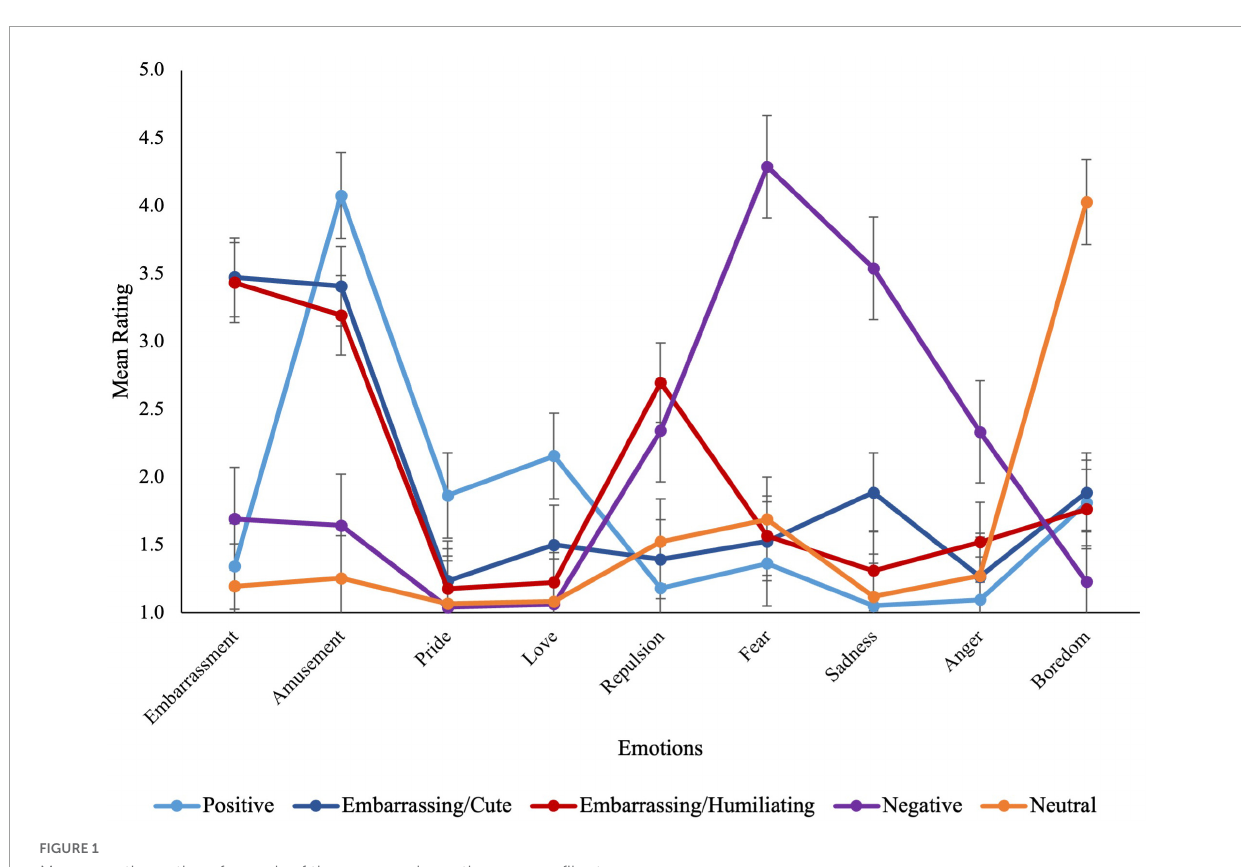
FIGURE1 Mean emotion ratings for each of the measured emotions across film